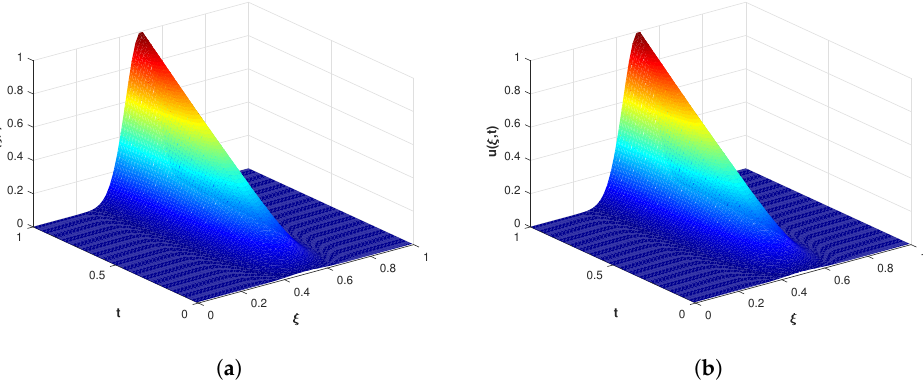
Figure 4. ( a ) Approximate solution of Problem 1 using α = 0.7, γ = 0.01. ( b ) Analytic solution of Problem 1 with γ = 0.01, α = 0.7. It is observed that the numerical solution and exact solutions are in good